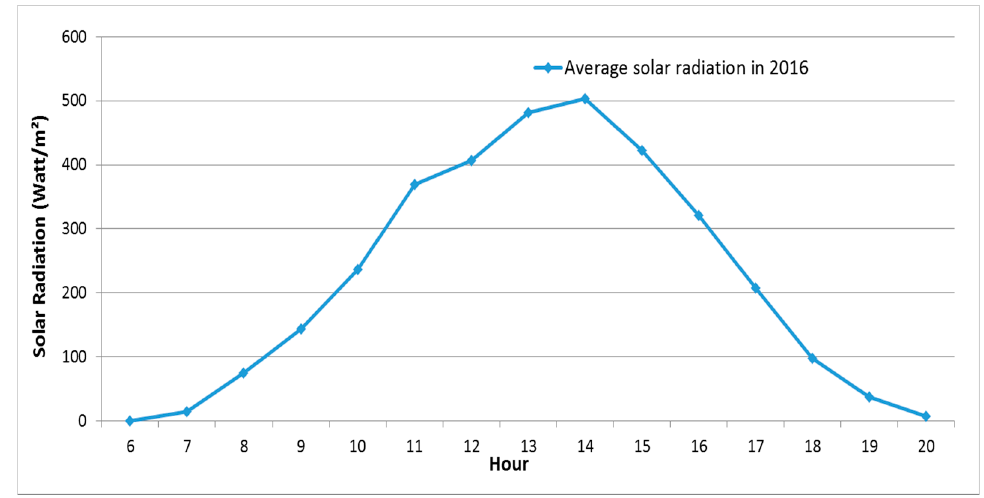
Figure 5. Annual average global radiation of 2016, from 06:00 to 20:00 h.